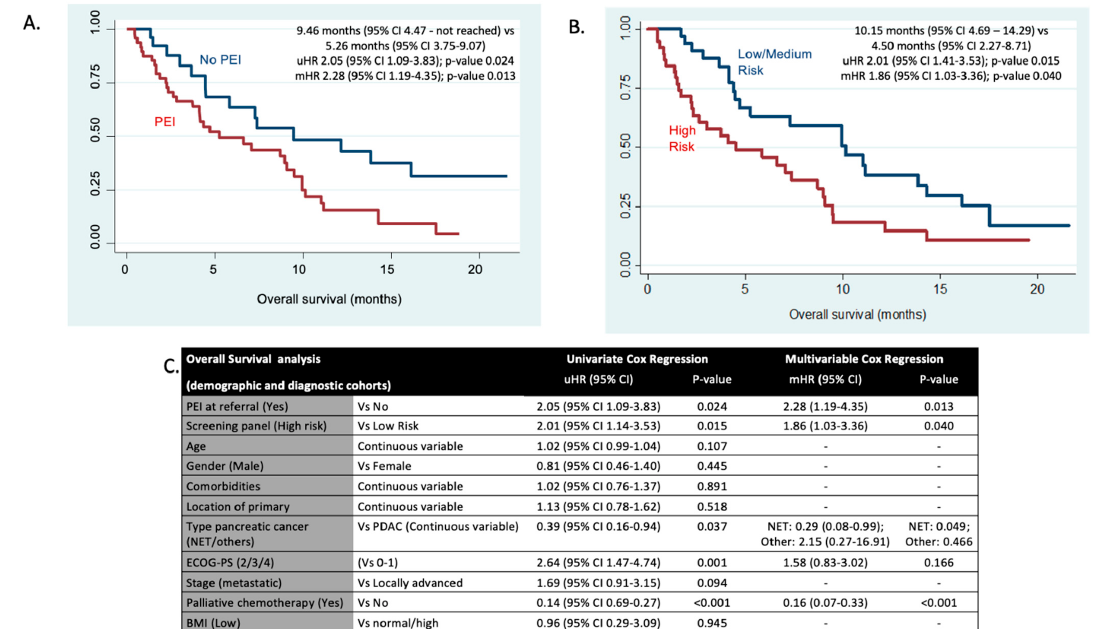
Figure 2. Joint survival analysis for demographic and diagnostic cohorts: both PEI and the screening panel were prognostic factors. Abbreviations: CI, con fi dence interval; ECOG-PS, Eastern Coopera- tive Oncology Group Performance Status; mHR, multivariable hazard ratio; NET, neuroendocrine tumour; PDAC, pancreatic ductal adenocarcinoma; PEI, pancreatic exocrine insu ffi ciency; uHR, uni- variate hazard ratio. ( A ) Kaplan-Meier curve for joint demographic and diagnostic cohorts compar- ing PEI vs. no PEI. ( B ) Kaplan-Meier cure for joint demographic and diagnostic cohorts comparing Low/Medium risk screening panel vs. High-risk screening panel ( C ) Overall survival analysis ad- justing for other prognostic factors.